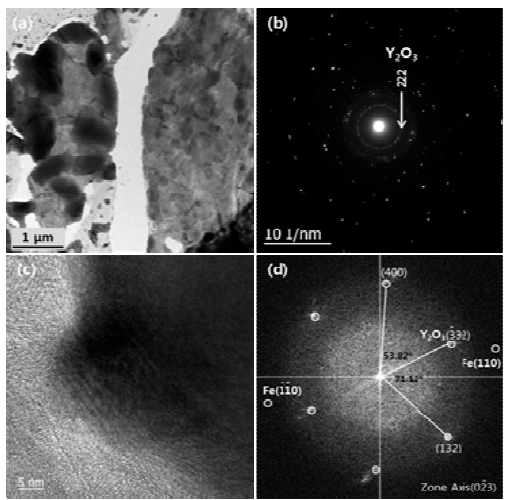
Figure 2. TEM (Transmission Electron Microscopy) analysis results of the mechanically alloyed Fe-10Cr-5Y 2 O 3 powders: ( a ) TEM image, ( b ) SAD (Selected Area Diffraction) pattern, ( c ) HRTEM (High Resolution Transmission Electron Microscopy) image, and ( d ) FFT (Fast Fourier Transformation) pattern.